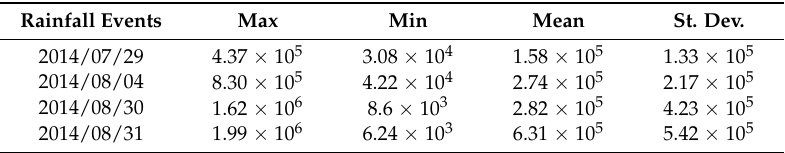
Table 2. Summary of statistics of FC